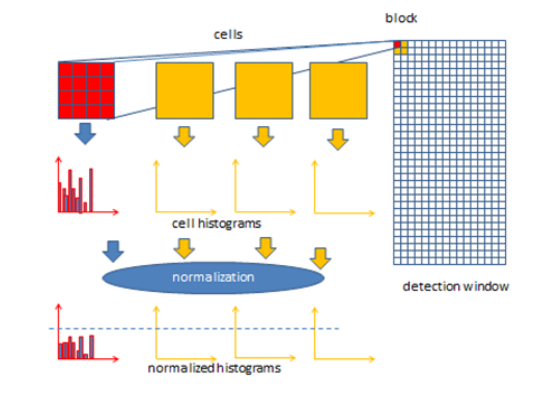
Figure 2. Extraction procedure of HOG feature The histogram for each cell is computed using